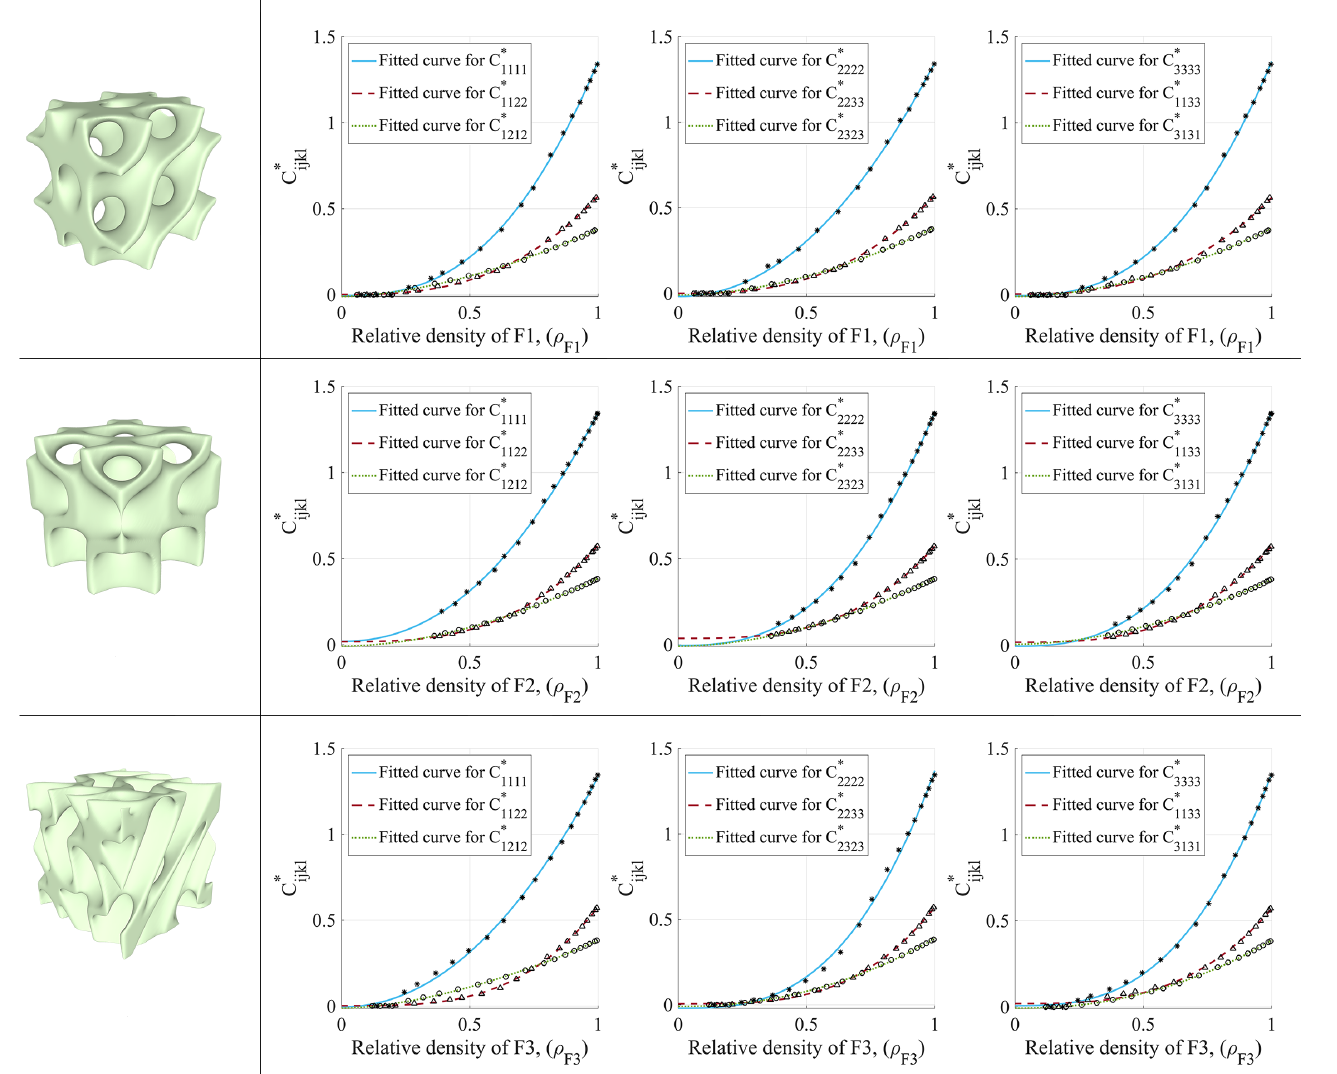
Figure 5. Elasticity tensor scaling laws for three orthotropic cellular materials, each orthotropic material has nine independent elements in its elasticity tensor. Each row belongs to one of the cellular materials shown in the left